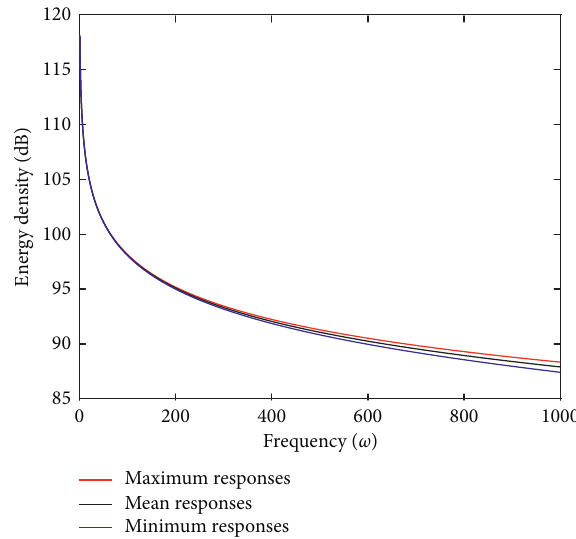
Figure 5: Energy density interval of the rod with a random-lo- cation excitation in frequency field. The reference energy density is 10 − 12 J/m 2 .